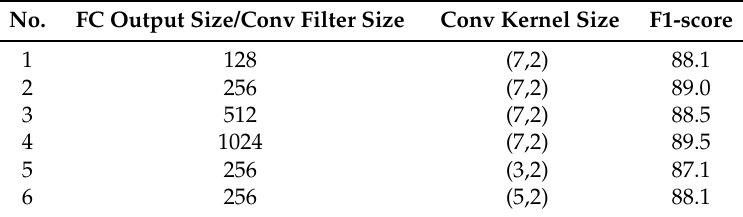
Table 5. F1-score (%) on house 2 data of the UK-DALE dataset. Fully connected (FC) output size/Conv filter size and Conv kernel size are tuned in Concatenate-DenseNet-121.